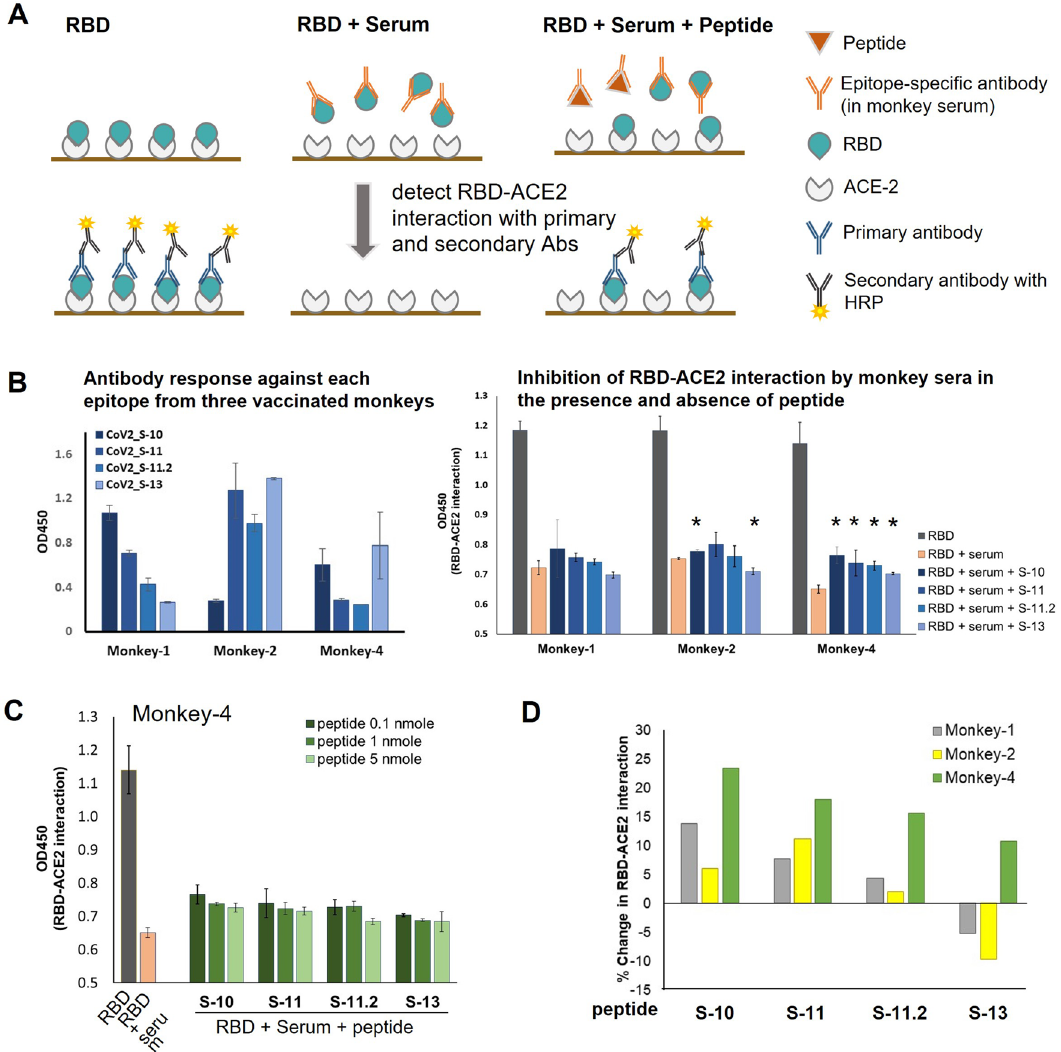
Figure 3. Competitive inhibition of RBD-ACE2 binding. ( A ) Schematic representation of the competitive inhibition of RBD-ACE2 interaction. The assay was performed based on the ELISA method. ELISA plates were coated with human ACE2. Binding between the RBD and ACE2 was measured in three different conditions: (i) RBD alone, (ii) RBD with monkey serum (diluted 1:500), and (iii) RBD with monkey serum and peptide. ( B ) Antibody response against each epitope observed in the three monkey sera used in the assay (left panel) and inhibition of RBD-ACE2 interaction by monkey antibodies in the presence and absence of peptide (right panel). * indicates a significant difference between the conditions with and without peptide ( p < 0.05). ( C ) Effect of peptide concentration on antibody blocking and RBD-ACE2 interaction. The assay was performed with three different concentrations (0.1, 1, 5 nmole/100 uL reaction) of peptide and the study with serum from vaccinated monkey number 4 is shown as a representative. ( D ) Percent change in RBD-ACE2 interaction in the presence of peptide. Percent change was calculated based on the formula described in the materials and